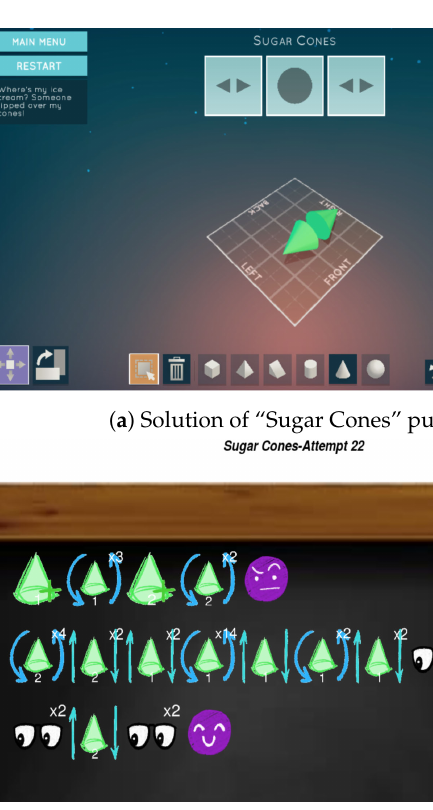
Figure 7. “Sugar Cones” puzzle and visualization examples in Shadowspect